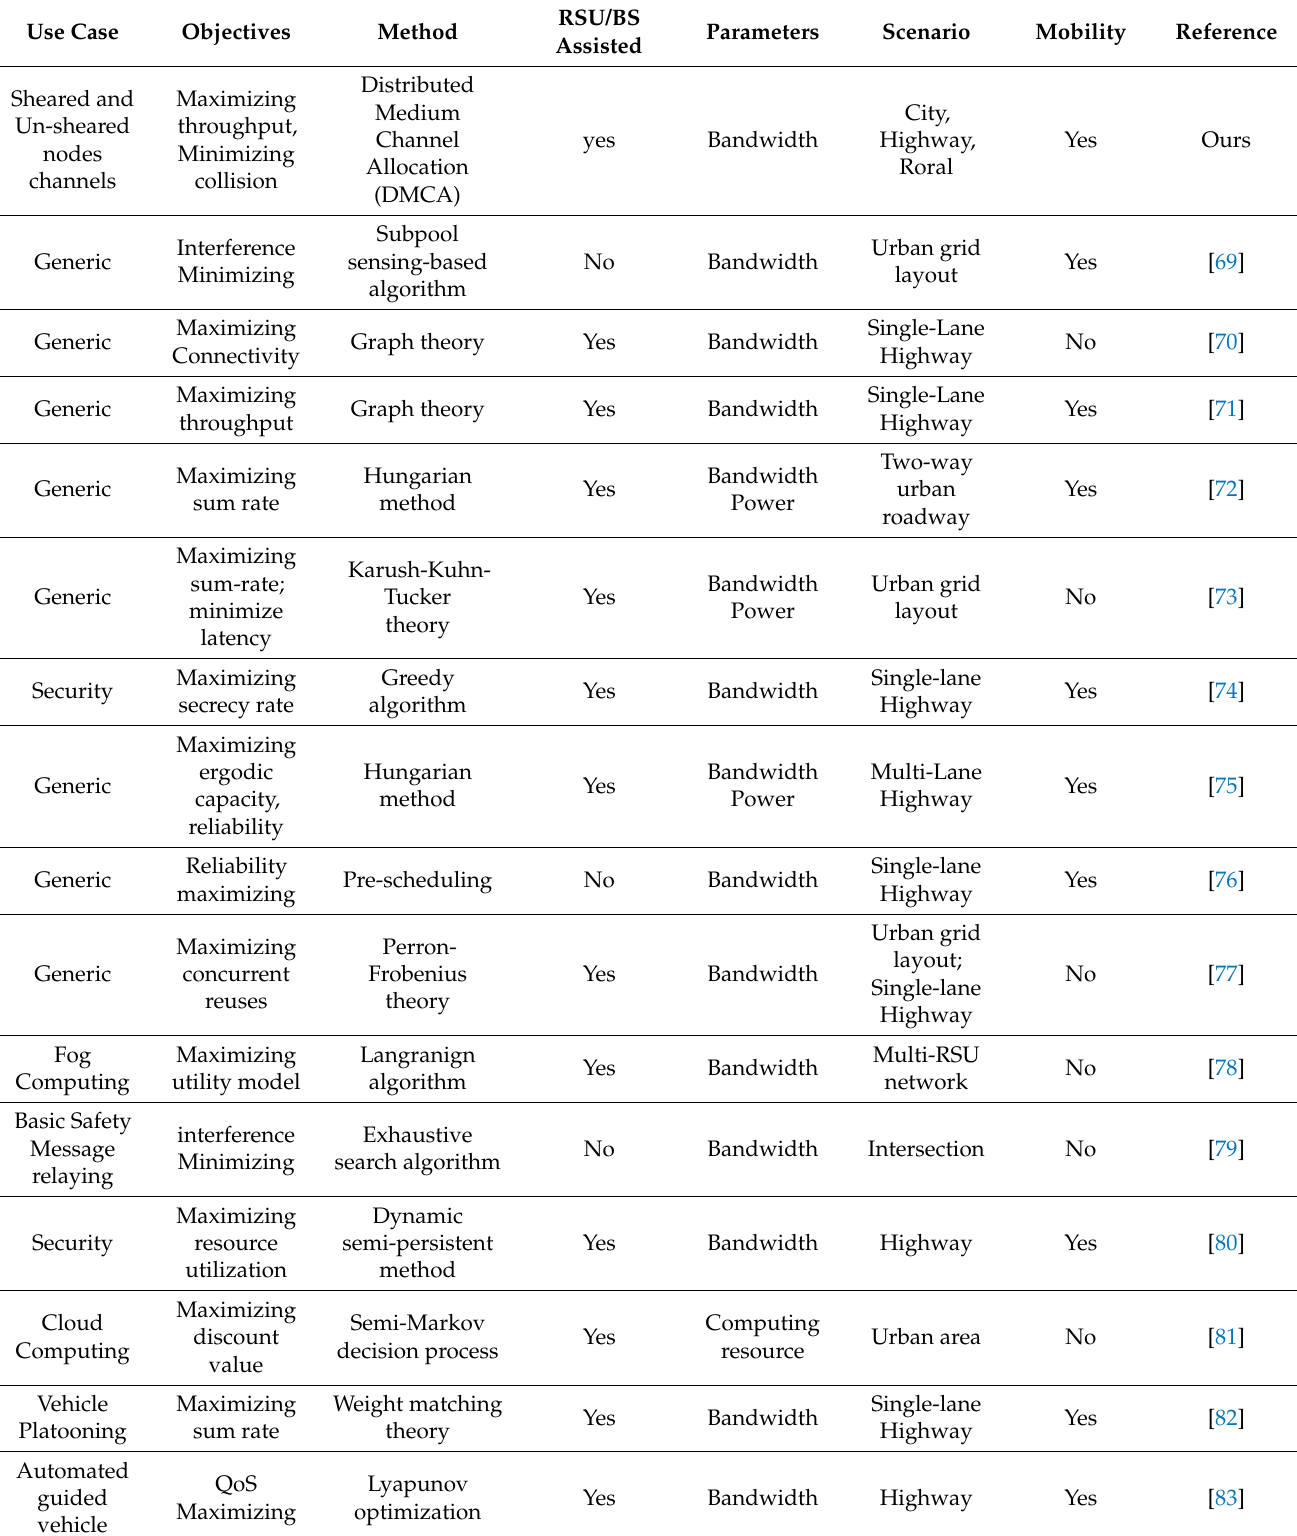
Table 5. Comparison of resource allocation techniques for V2X